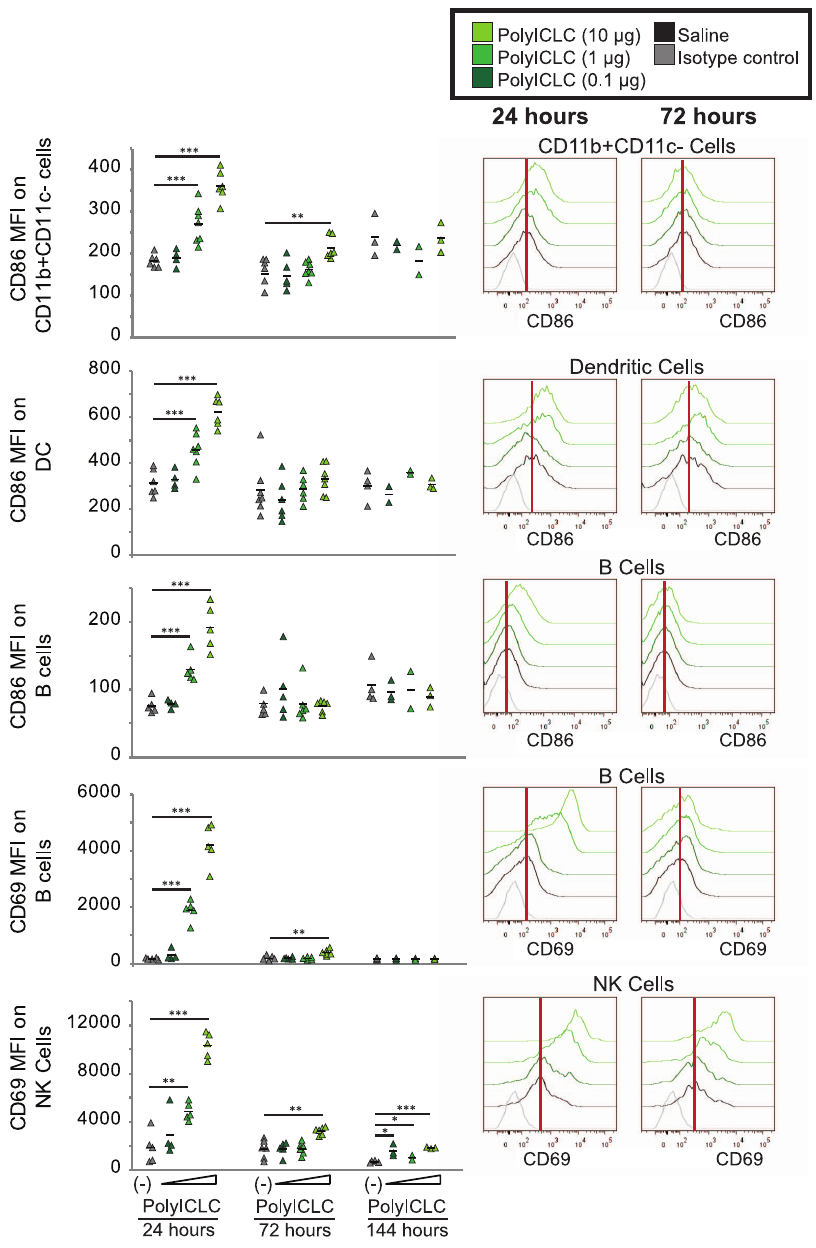
Figure 6. PolyICLC induces transient activation of cells in the draining lymph node . C57BL/6 mice were vaccinated IM with saline or 0.1 m g, 1 m g, or 10 m g of polyICLC (dose level indicated by triangle), and the popliteal lymph node was collected 24, 48, or 144 hours after vaccination. Viable cells were stained for common innate immune markers as well as CD19 for B cells and NK1.1 for NK cells. The mean fluorescence intensity (MFI) of CD69 and CD86 were used to evaluate the activation of appropriate cell populations. Dot plots to the right indicate gating of the parent cell after gating on viable lymphocytes. Histograms show CD86 and CD69 expression on the parent cells 24 hours and 72 hours after vaccination. 200,000– 500,000 events were collected in duplicate for each animal. P values were determined using the Student’s T-test by comparing the percentage of responding cells in animals vaccinated with VLP alone versus vaccination with VLP and various doses of polyICLC. ‘‘*’’ indicates p , 0.05, ‘‘**’’ indicates p , 0.005, and ‘‘***’’ indicates p , 0.0005. Four to five animals were utilized in each group for each iteration of this experiment.